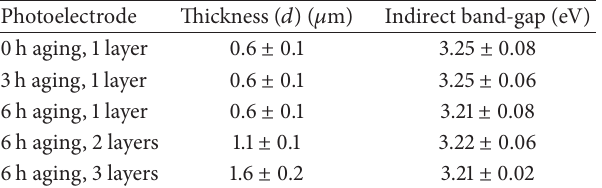
Figure 1: Rheology measurements showing how the viscosity and shear stress of the sol change during the aging process. photoelectrodes measured by Table 1: Thickness of sol-gel TiO 2 SEM. The indirect band-gap obtained from the Tauc plot [25] applied to the optical data in Figure 3 is also